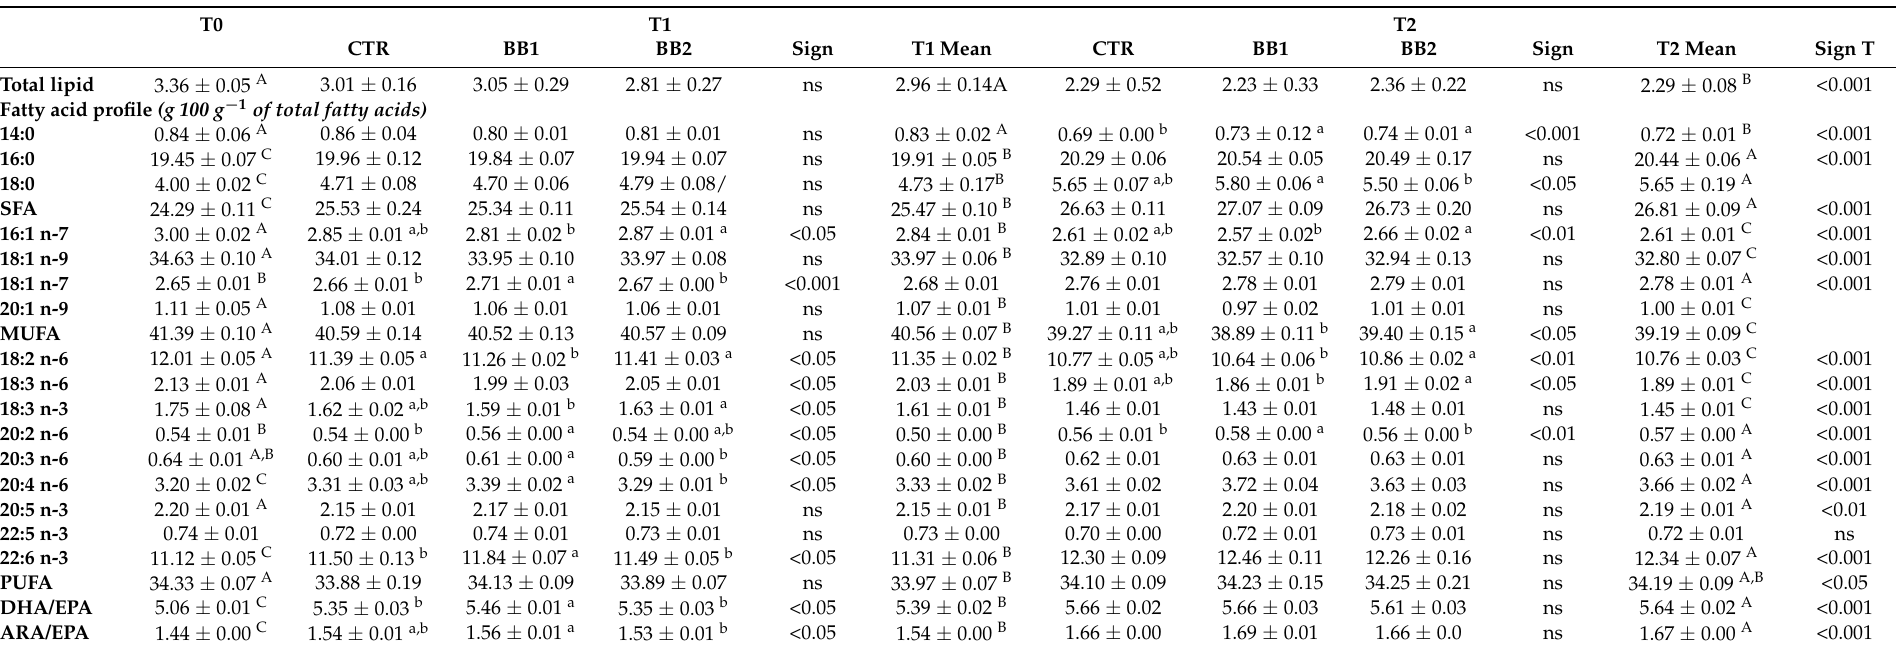
Table 1. Lipid content (mg/larvae) and fatty acid composition (g 100 g − 1 of total fatty acids) of larvae according to the stage of development (T0, T1, T2) and the different treatments tested (CTR, BB1, BB2). Data are presented as LSM ±